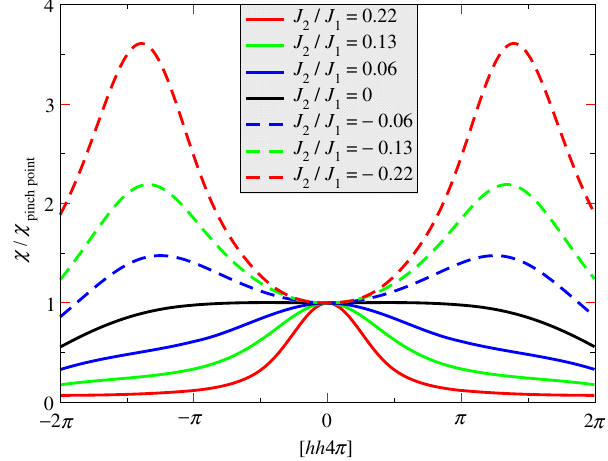
FIG. 20. For the S ¼ 1 = 2 J 1 - J 2 model, the susceptibility plotted along the ½ hh 4 π (cid:2) cut (white line in Fig. 18) evaluated at T=J ¼ 1 = 100 for different J 2